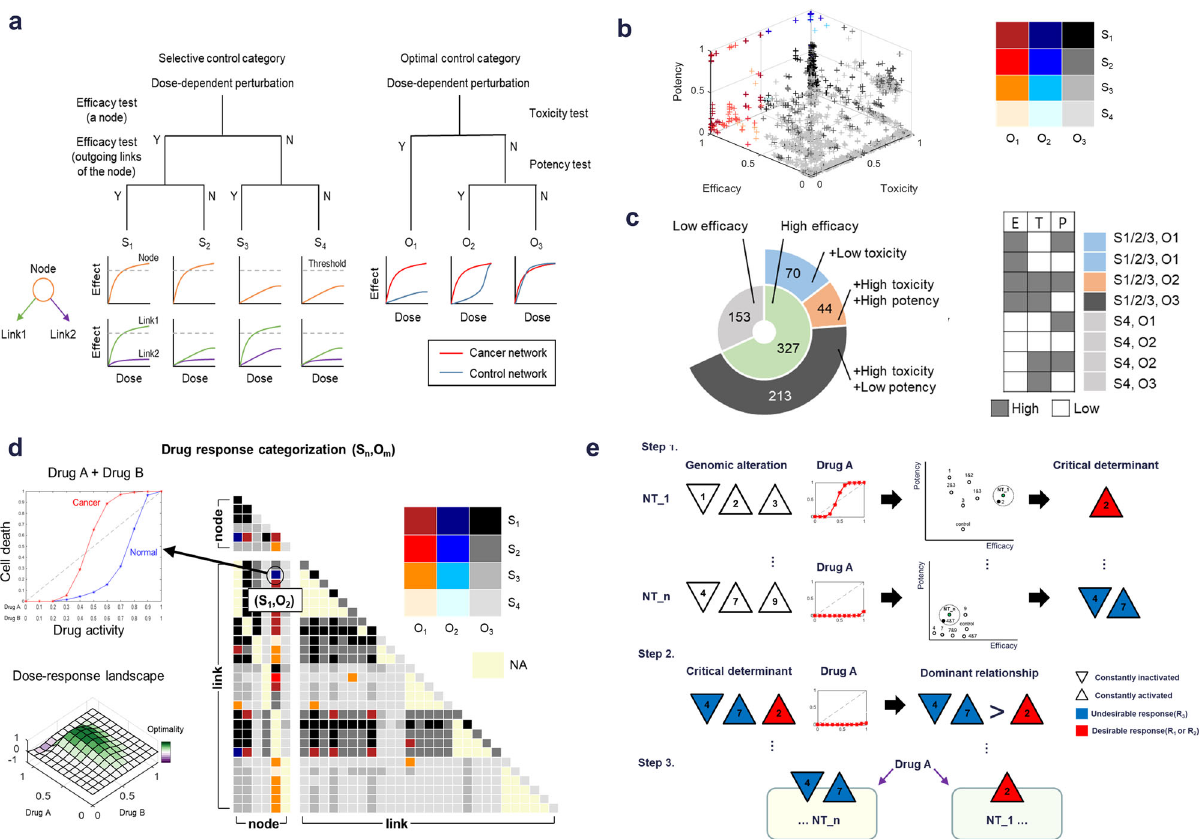
Fig. 3 Target screening and patient strati fi cation using drug response categorization. a Categorization of for according to “ selective control ” group as S 1 – 4 by ef fi cacy using dose – response curves obtained from simulation of inhibition of a target node and its outgoing links (left). Categorization of responses according to “ optimal control ” group as O 1 – 3 by toxicity and potency by comparing to dose – response curves obtained from simulation of cancer and control networks with inhibition of a target node or link (right). b All the drug responses from 17 cancer networks with 480 perturbations were plotted based on ef fi cacy, potency, and toxicity. Colors denote 12 drug response categories (S n ,O m ). c Distribution of the 480 perturbations in cancer networks with regard to the response categorization. d The example triangle map representing all the response categories of 480 drug perturbations to screen for optimal targets for a single cancer-cell network. Each square on the triangle map represents the (S n ,O m ) classi fi cation obtained from the dose-dependent simulation for corresponding drug or drugs. The NA denotes the case of a link combination in which the two links were from the same node or the case of a node-link mixed combination in which the link from a node were combined with that node. The graph shown in the upper left represents the dose – response curve for corresponding drug or drugs. The graph in the lower left represents the dose – response landscape for corresponding drug combinations. e Illustrative work fl ow to identify critical determinants and their dominance relationship for patient strati fi cation. For each cancer network, we analyze dose – response curves of all the subnetworks, including the control network, in the two-dimensional ef fi cacy – potency plot (step 1). The critical determinant is the common and minimum genomic alteration(s) among the networks exhibit the same drug response with the original cancer network. By determining the effect of combinations of the genomic alterations to the drug response curve, we establish the dominance relationships among them (step 2). We can predict the response of cancer networks and stratify them using critical determinants and their dominance relationship (step